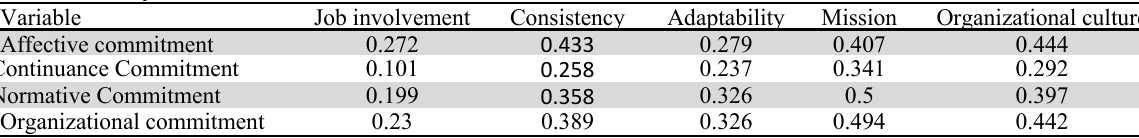
The summary of Pearson correlation